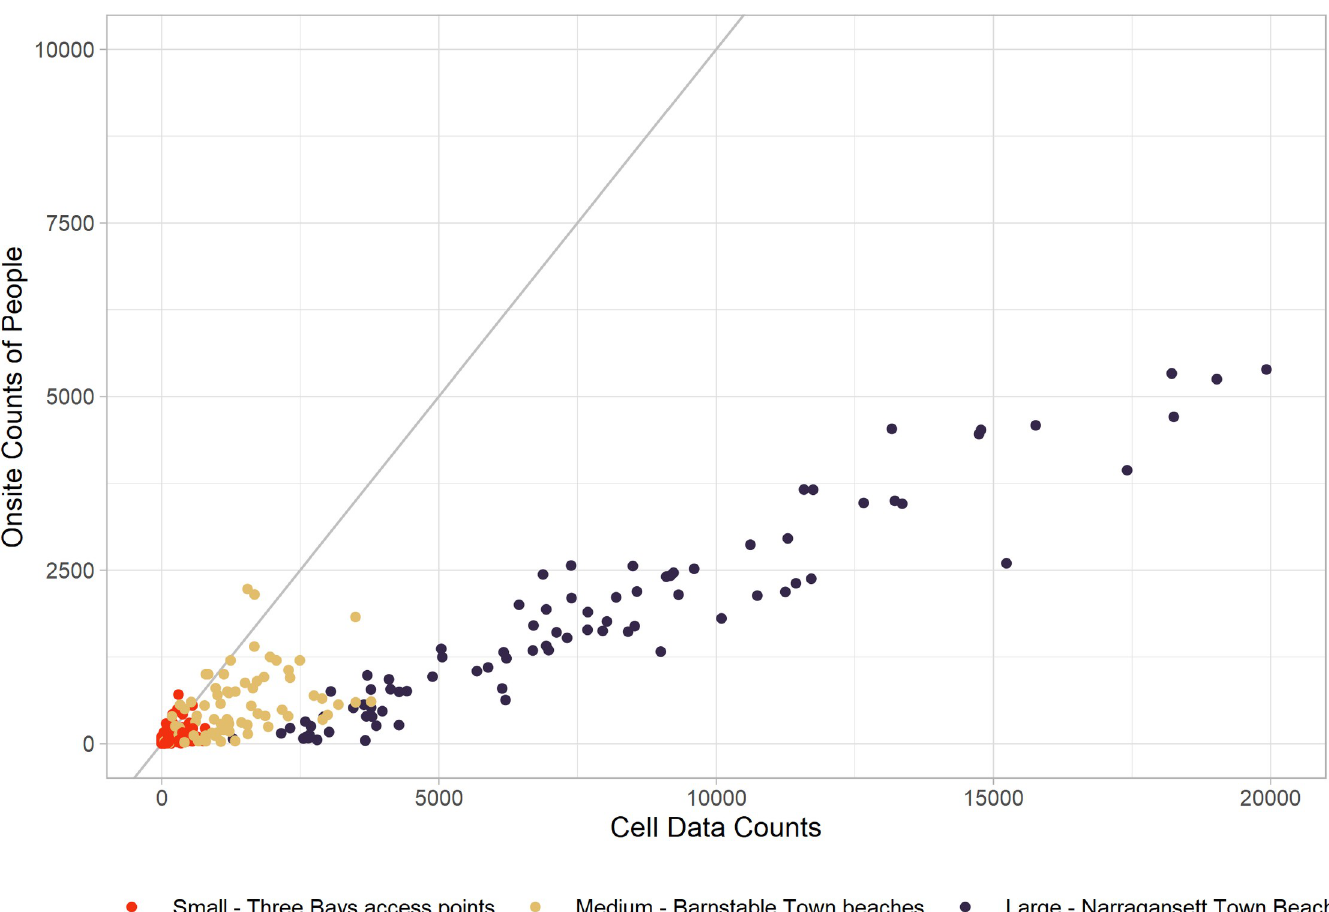
Fig 2. Observational counts compared against cell data. Observations of visitation (9AM-4PM) plotted against uncalibrated visitation estimated from the cell data for the same hours.